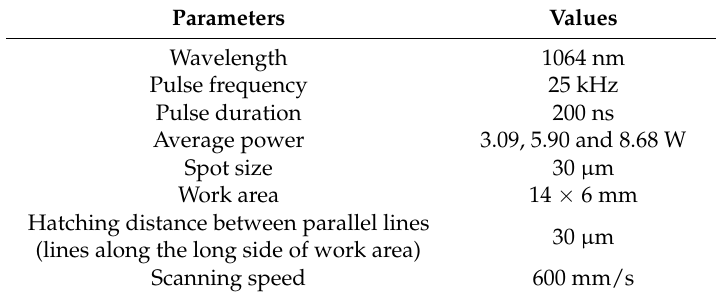
Figure 1. Work station for laser modification of nanodiamond: ( a ) picture of the system ( b ) scheme of the scanner head. Table 1. Parameters of laser system used during nanodiamond particle (NDP) treatment process.